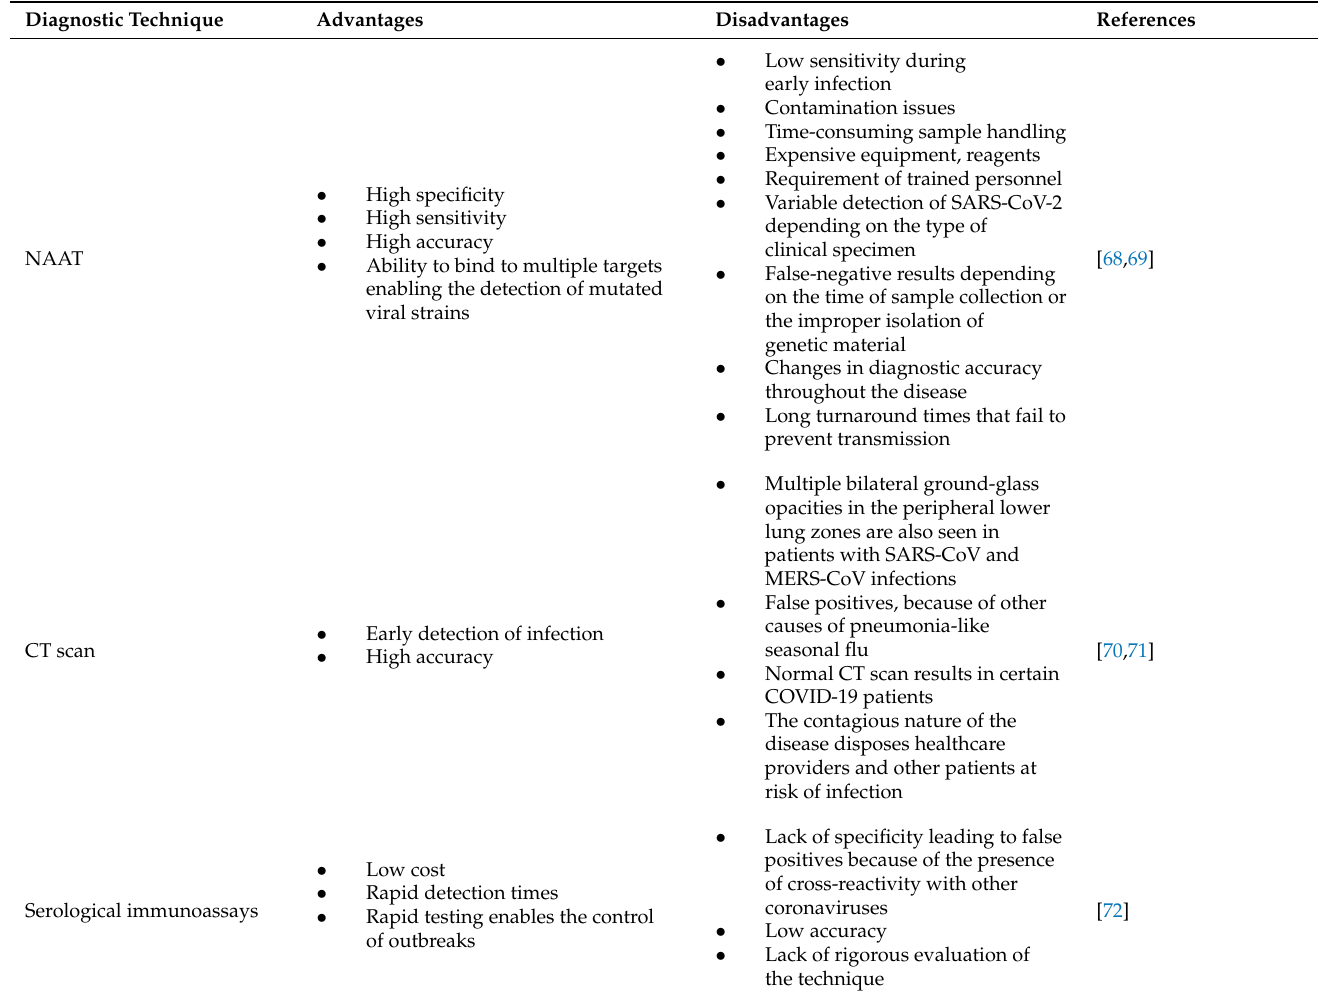
Table 3. Advantages and disadvantages of various diagnostic tests used for SARS-CoV-2